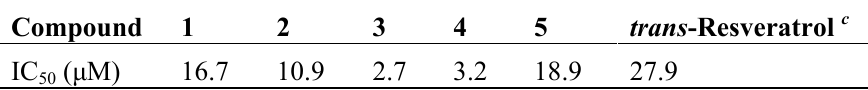
Table 3. Inhibitory effects of compounds 1 – 5 against α -glucosidase ( n =